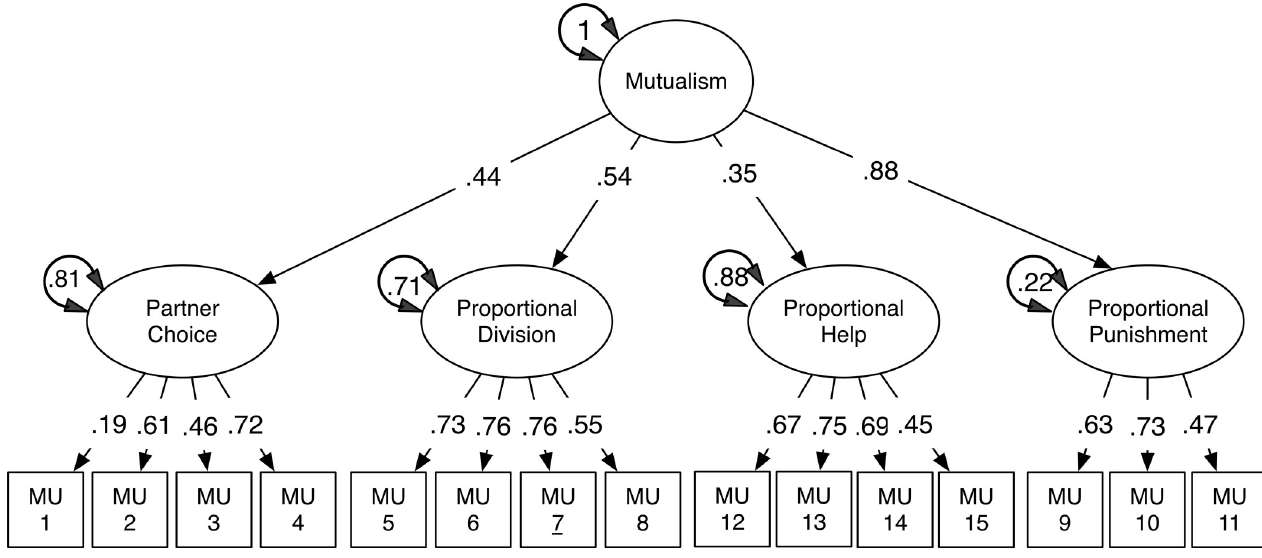
Fig 4. Replication of measurement model of the mutualism scale, Study